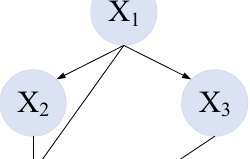
Table 1. CPT corresponding to the AND gate in FT (Occ: occurred; Non: non-occurred). X 1